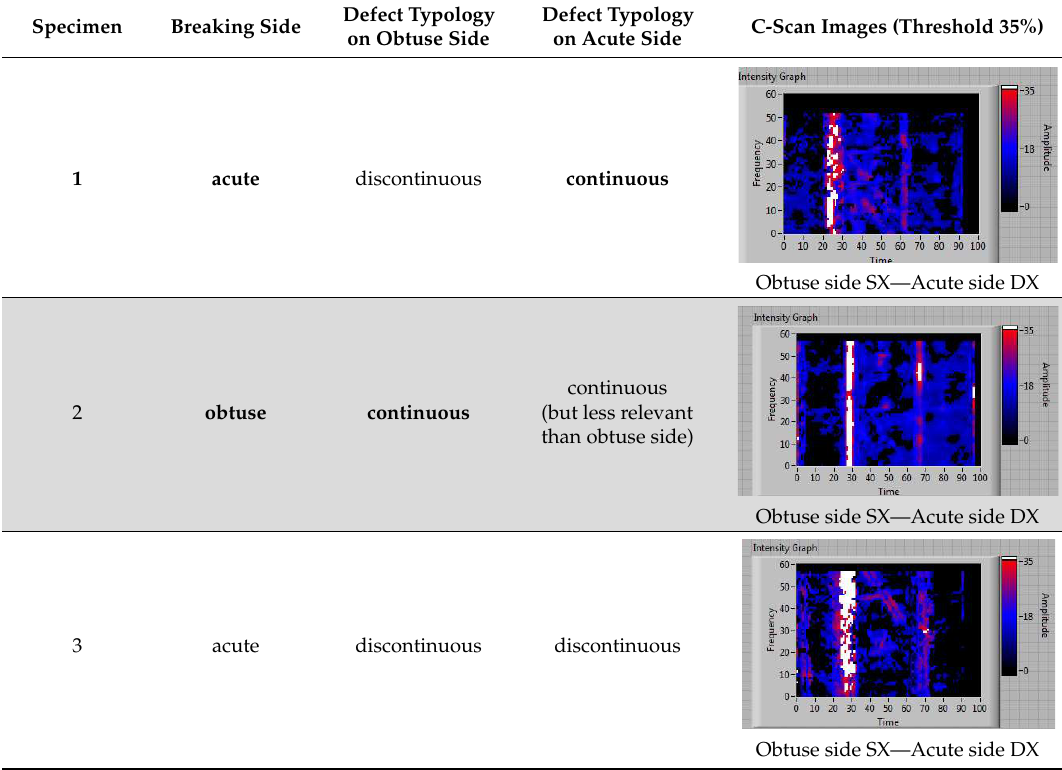
Table 3. Correlation between the breaking side of specimen and the defectiveness characteristics.